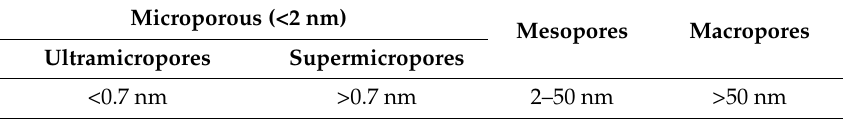
Table 1. Standard classification of porous materials as a function of their pore size.